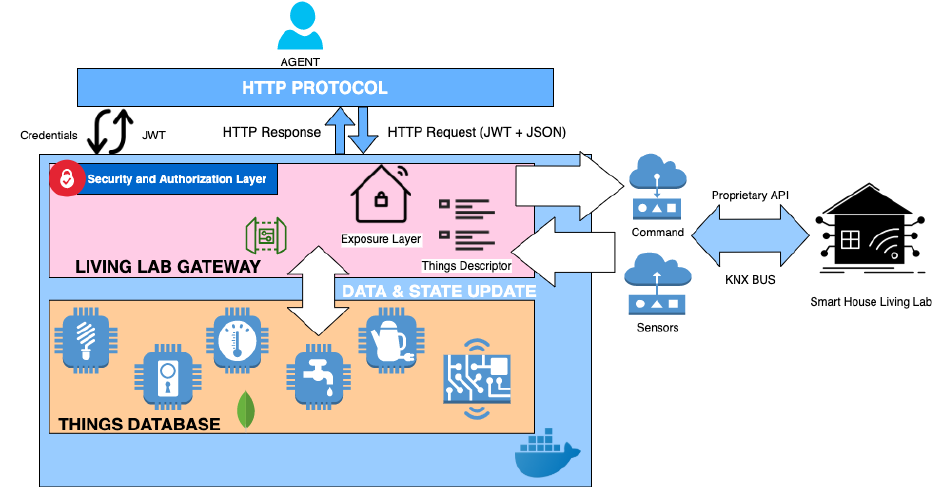
Figure 2. Living Lab Gateway